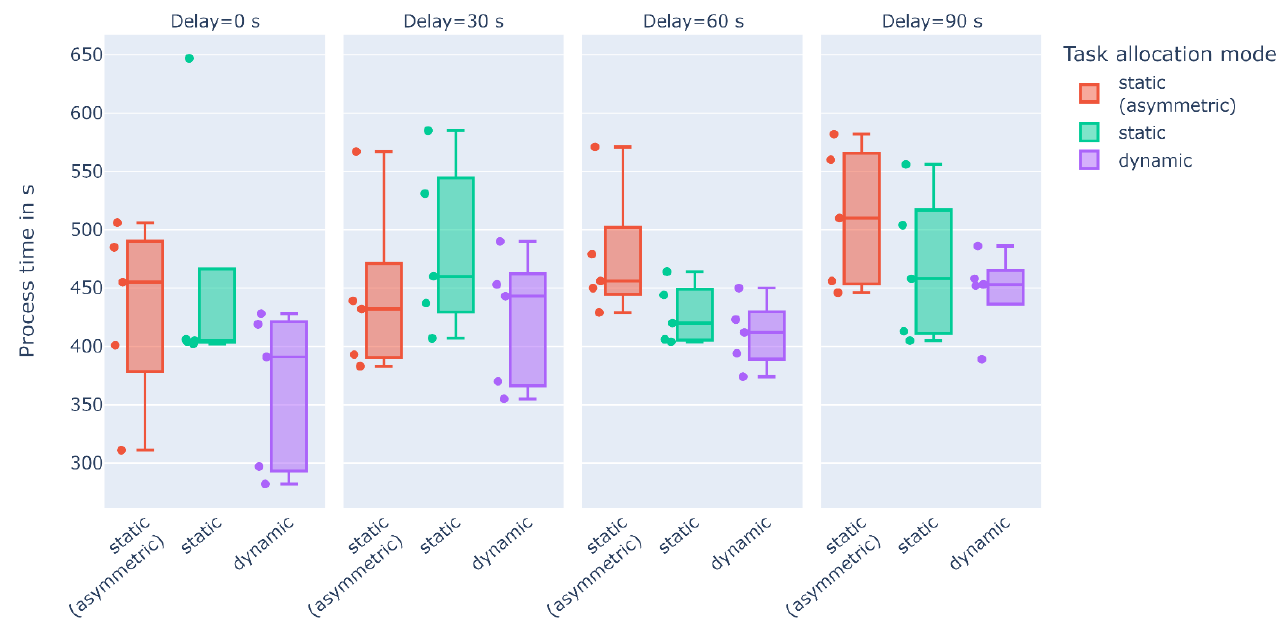
Figure 19. Comparison of task allocation modes depending on duration of human task delay for assembly of three components.